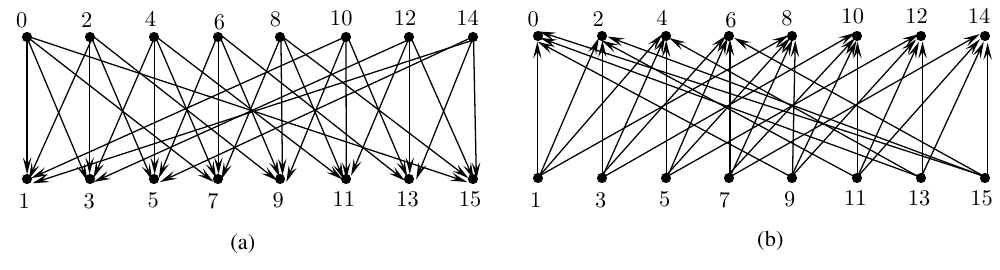
−→ −→ G 5 ,e and G 5 ,o , in Figure 4, in the “natural” bipartite structure. For example the edges of Fig. 5: Redrawings of distance 7 in ~G 5 ,e are edges of jump 3 from X to Y, where X = { 0 , 2 , 4 , . . . , 14 } and Y = { 1 , 3 , 5 , . . . , 15 } , in the bipartite structure. Actually, an edge of distance 2 ℓ − 1 in ~G k,e becomes an edge of jump 2 ℓ − 1 − 1 , from X to Y, in the bipartite structure. As the graphs of Figures 4(a) and 4(b) are isomorphic, the graphs in Figures 5(a) and 5(b) are isomorphic (the isomorphism is obtained by mapping the vertex i in Figure 5(a) to i + 1 ( mod 2 k − 1 ) of Figure